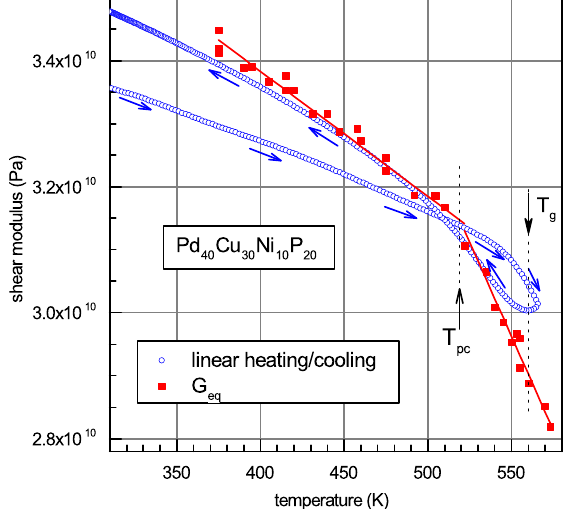
Cu Ni P 40 30 10 20 pc